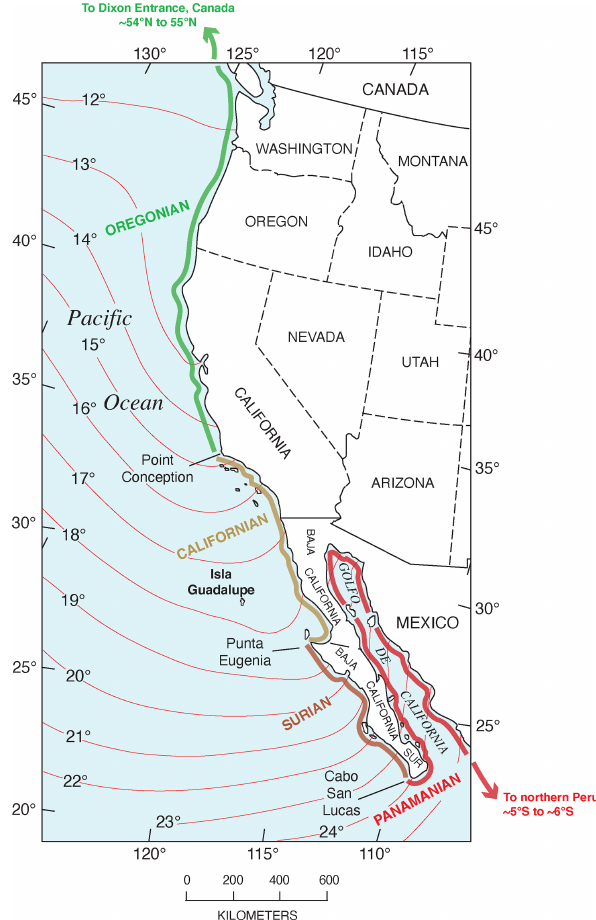
Figure 43. Map of a part of the Pacific coast of North America showing marine invertebrate faunal zones (from Valentine, 1966) and their correlation with mean annual sea surface temperatures (temperature data from U.S. National Oceanic and Atmospheric